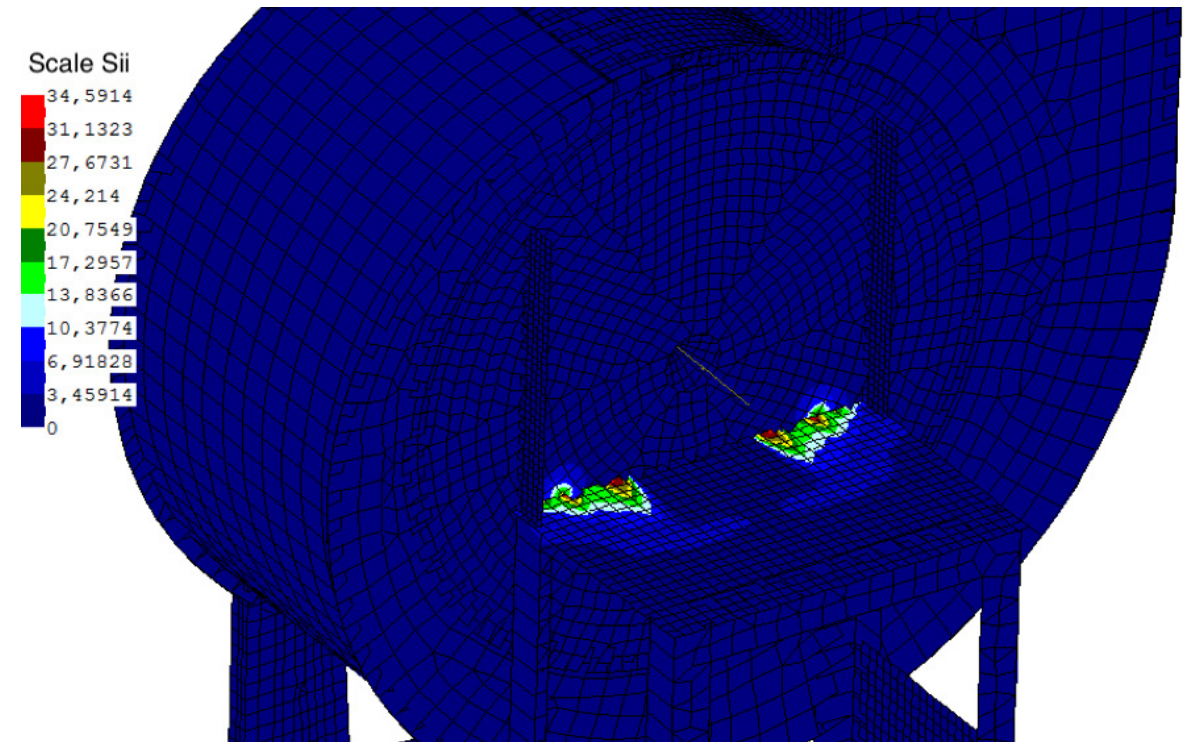
Figure 6. Amplitude values of reduced stresses of the ventilator calculated by linear spectral method,